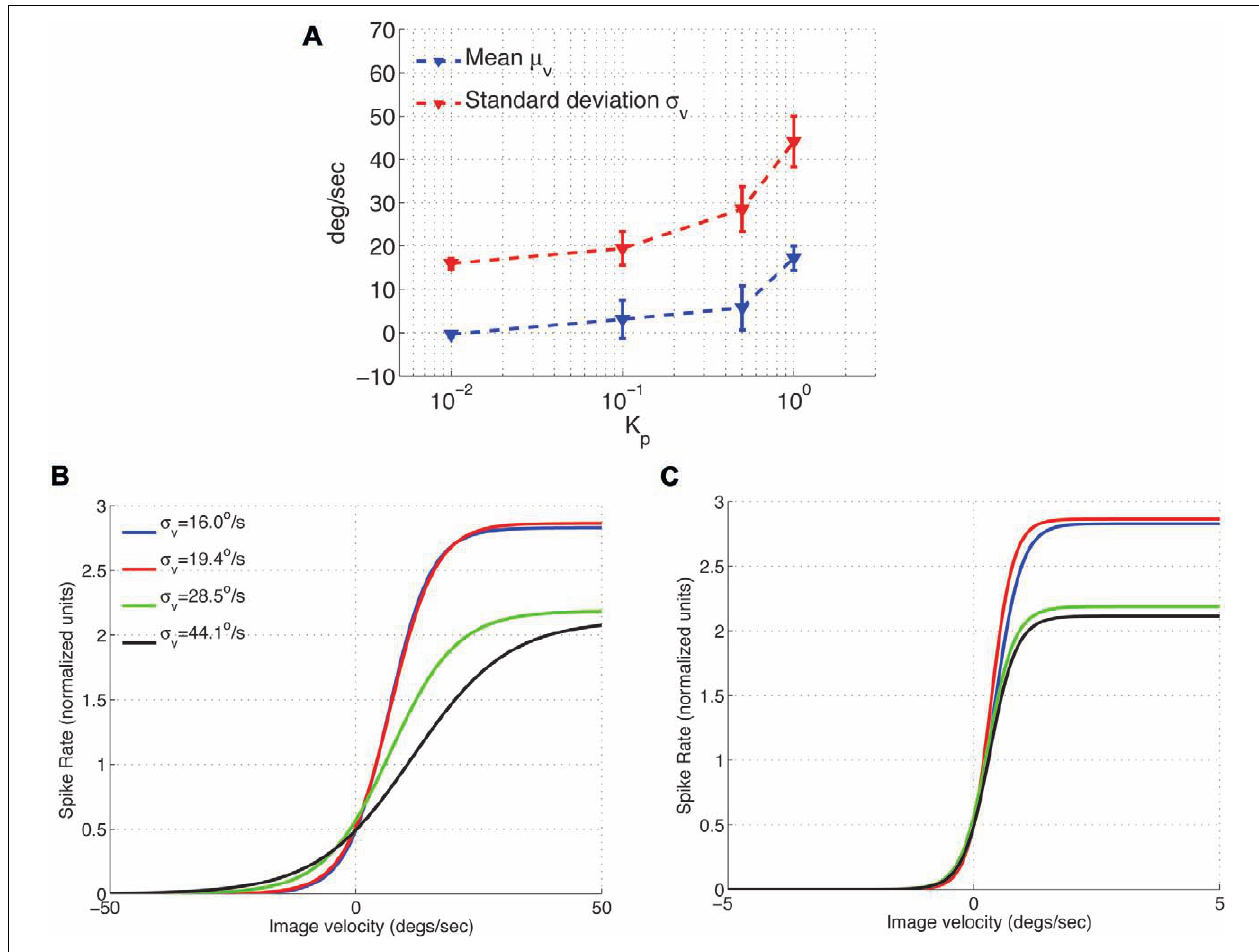
FIGURE 3 | Effect of the image velocity mean and standard deviation on the adaptive scaling properties of the H1-cell response function (A) Mean and standard deviation of the H1 input (slip speed). (B) The fitted H1-cell response functions adapts to accommodate the increased standard